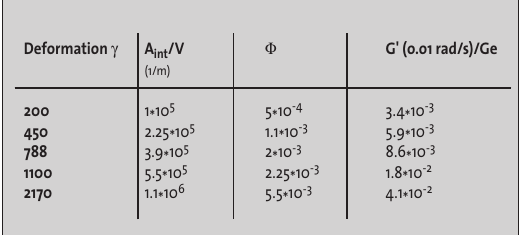
Figure 6 (left): G’ (o.o1)/Ge as a function of Φ (average). Table 4 (right): Interfacial area per unit volume and estimated volumic fraction of the crosslinked phase as a function of applied